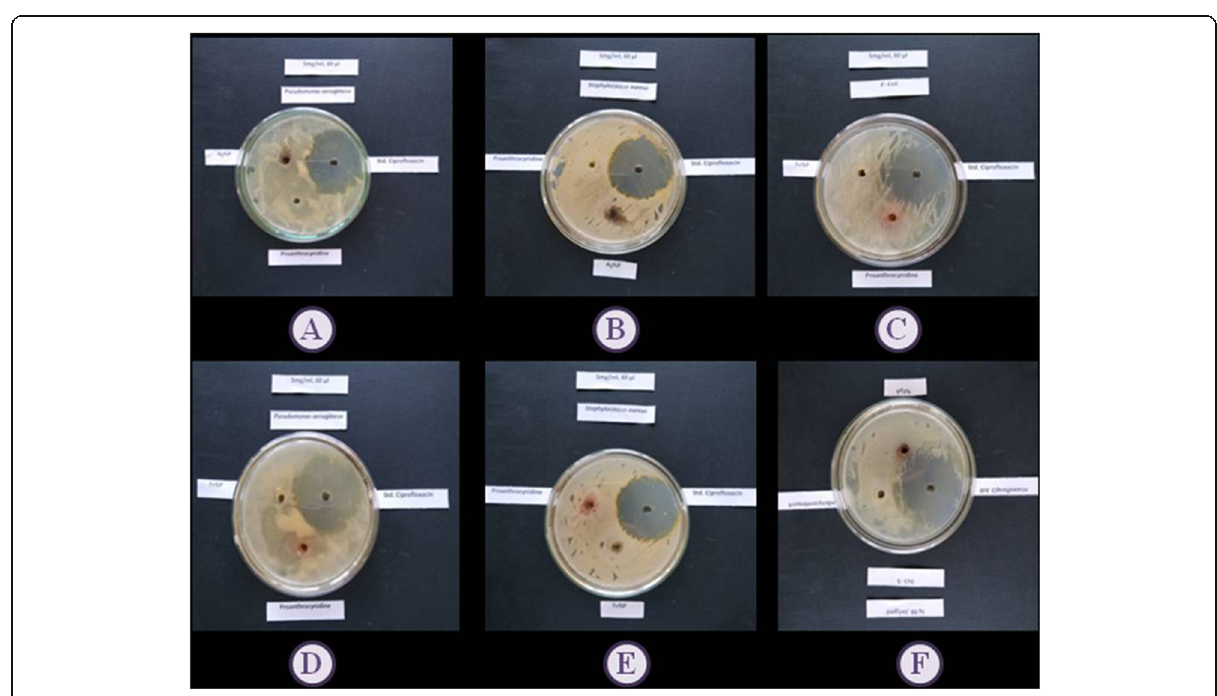
Fig. 3 Antimicrobial activity